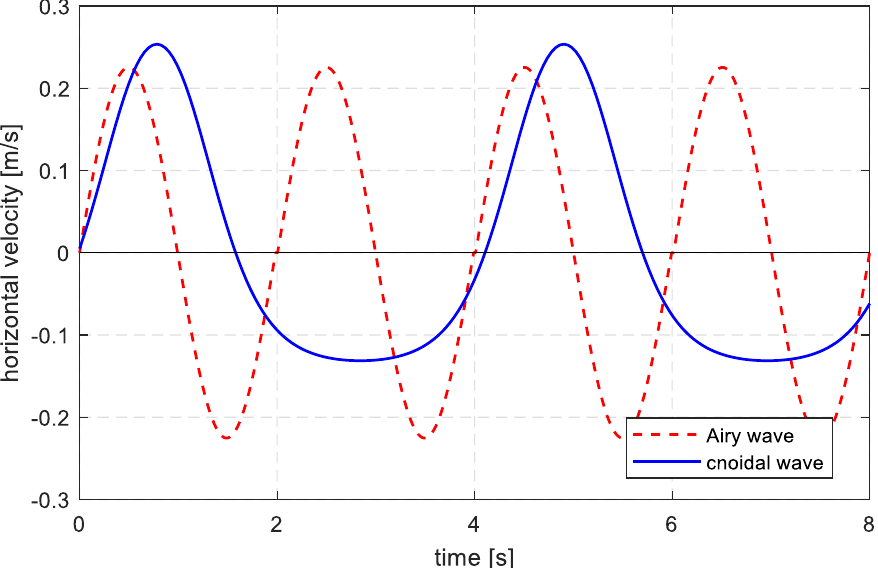
Figure 3. Time series of the wave particle horizontal velocity with different wave theories. The red dash line represents the first test and the wave velocity is symmetrical in a wave period. The blue solid line represents the second test and the wave velocity is larger following the wave direction but the duration is shorter.